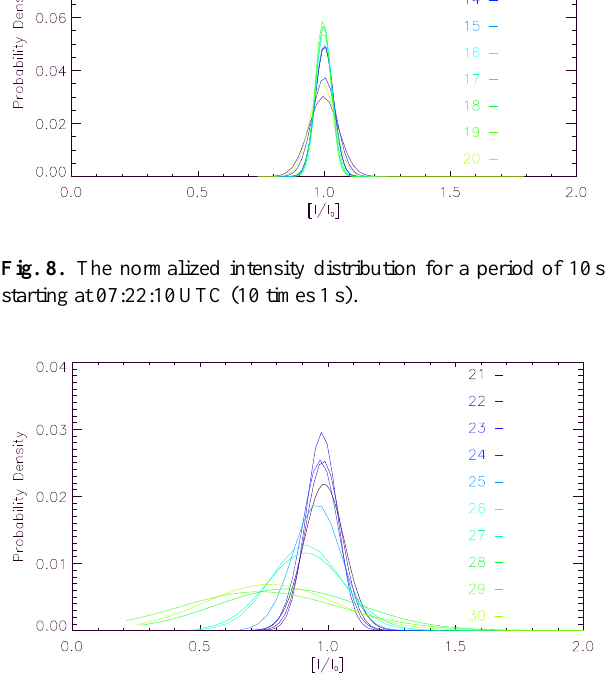
Figure 9 The normalized intensity distribution for a period of 10 seconds starting at 07:22:20 UTC (10 times 1 second). Fig. 9. The normalized intensity distribution for a period of 10s starting at 07:22:20UTC (10 times